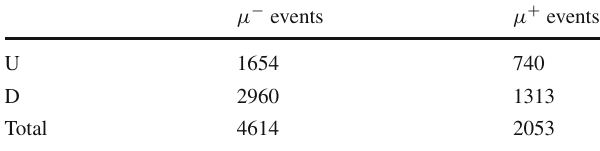
Table 2 Total number of upward-going (U) and downward-going (D) μ − and μ + events expected at the 50 kt ICAL detector in 10 years (total exposure of 500 kt · yr). We use the oscillation parameters